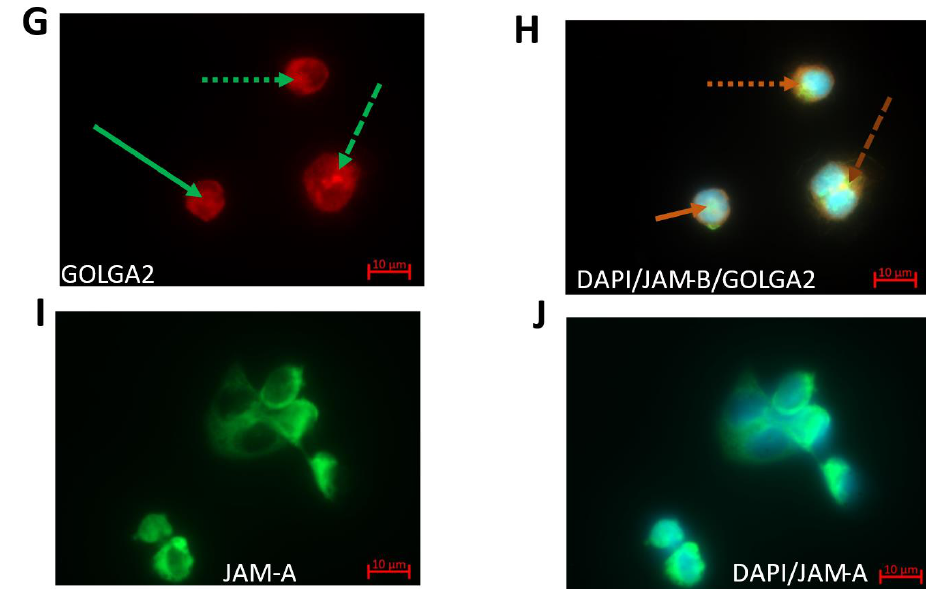
Figure 5. Immunofluorescence of DAPI, JAM-B and G130 using a mouse anti-JAM-B monoclonal antibody (SC-293496) and an anti-GM130 polyclonal antibody (PA1-077) in THP-1 monocytes ( A – D ) and macrophages ( E – J ). ( A ) DAPI nuclear staining in THP-1 monocytes; ( B ) JAM-B staining in THP-1 monocytes; ( C ) G130 Golgi staining in THP-1 monocytes (stains peripheral membrane component of the cis-Golgi stack marker GOLGA2); ( D ) composite image showing co-localisation of JAM-B and G130; ( E ) DAPI staining in THP-1-differentiated macrophages; ( F ) JAM-B staining in THP-1- differentiated macrophages showing polarised staining (dotted line), in splitting nuclei (dashed line), inside the nucleus (solid line); ( G ) cis-Golgi stack marker GOLGA2; ( H ) composite image showing DAPI, JAM-B and GOLGA2 staining. At least three technical replicates were carried out. JAM-B staining contrasts with that of JAM-A ( I ) (JAM-A staining) and ( J ) (composite JAM-A and DAPI